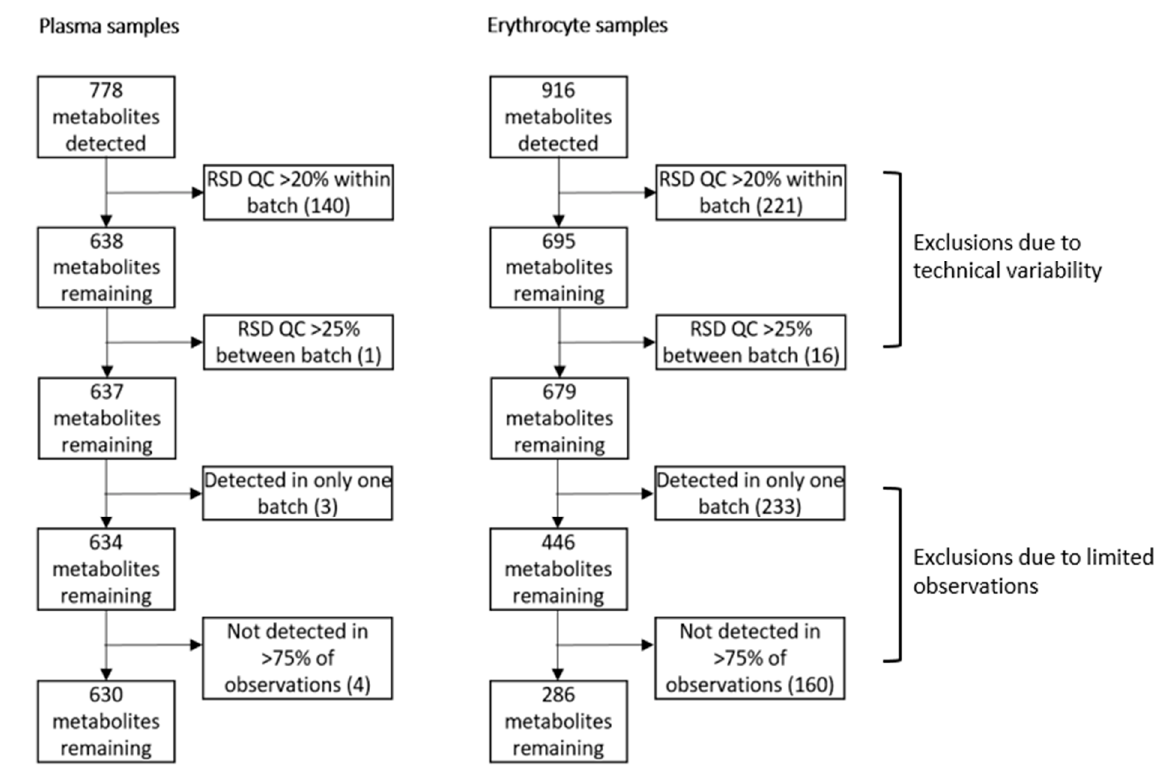
Figure 1. Pre ‐ processing steps and exclusion numbers of Lipidyzer variables. Lipid metabolite variables were excluded if the relative standard deviation (RSD) of the quality control (QC) was >20% within a batch, or >25% between separate batches if a lipid was detected in one batch only or not detected in >75% of the observations. Table 1. Number of individual lipids per class and class concentrations in plasma and erythrocytes.